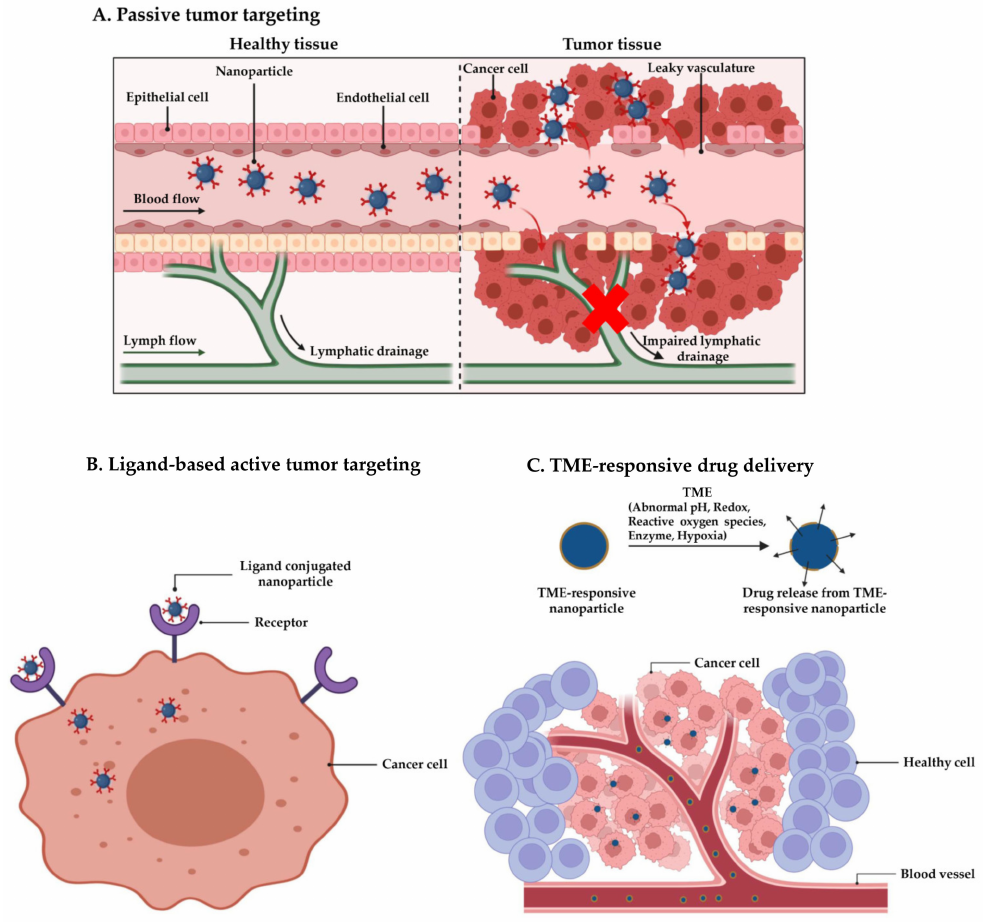
Figure 1. Nanocarrier-mediated tumor targeting. ( A ) Passive tumor targeting, ( B ) ligand-based active tumor targeting, and ( C ) TME-responsive drug delivery. Created with